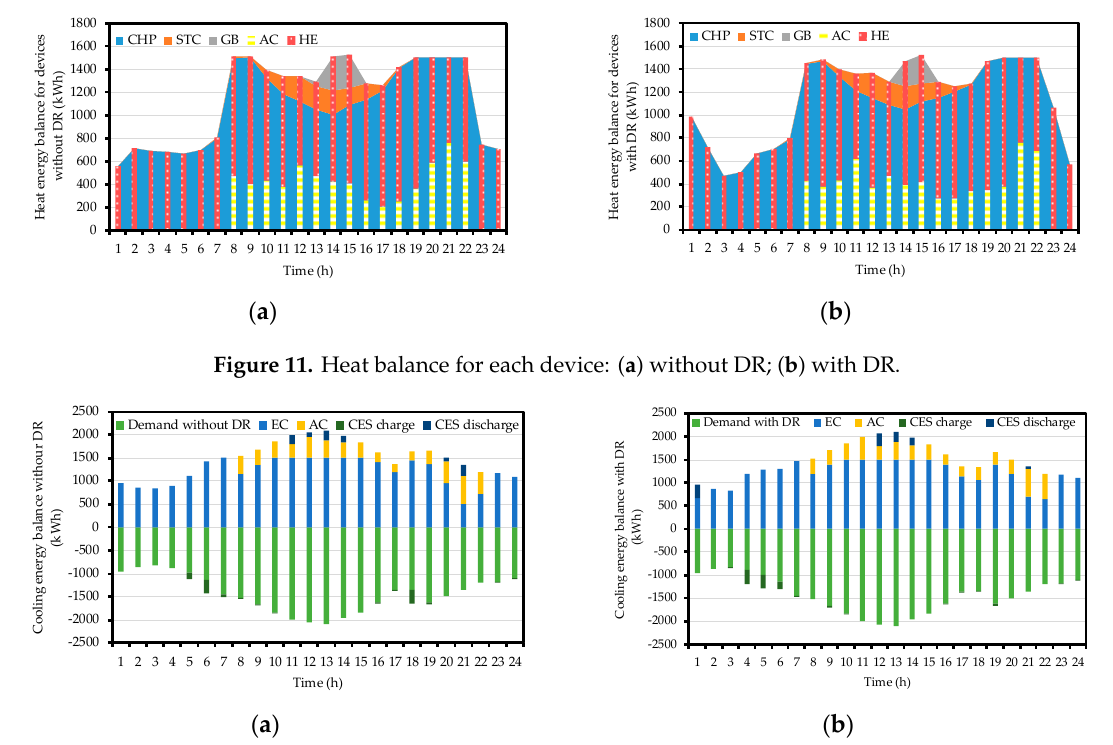
Figure 10. Optimal scheduling results for heat: ( a ) without DR; ( b ) with DR.